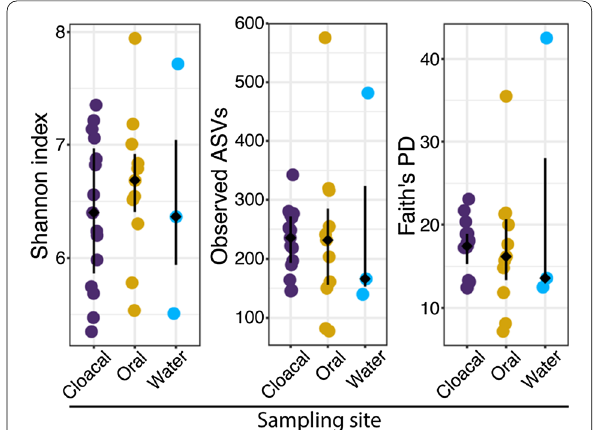
Fig. 1 Alpha diversity (Shannon index, observed ASVs, Faith’s Phylogenetic Diversity) of loggerhead cloacal (purple), oral (yellow), and tank water (blue) samples. Filled diamond indicates sample median with lines extending to the upper and lower quartile of sample